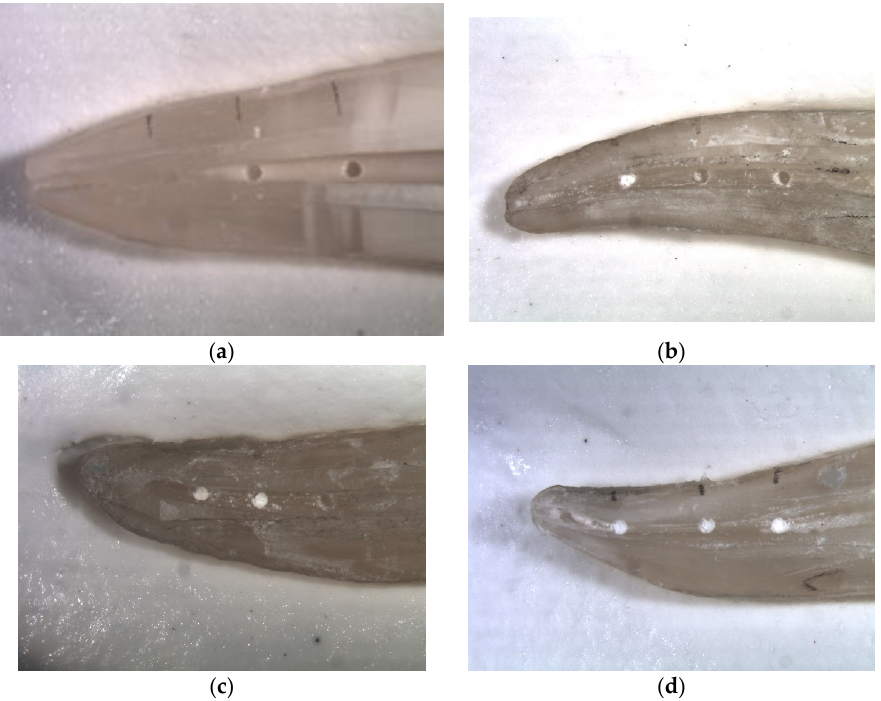
Figure 2. ( a ) Score 0: 0–25% of the holes filled with debris; ( b ) Score 1: 26–50% of the holes filled with debris; ( c ) Score 2: 51–75% of the holes filled with debris; ( d ) Score 3: 76–100% of the holes filled with debris.